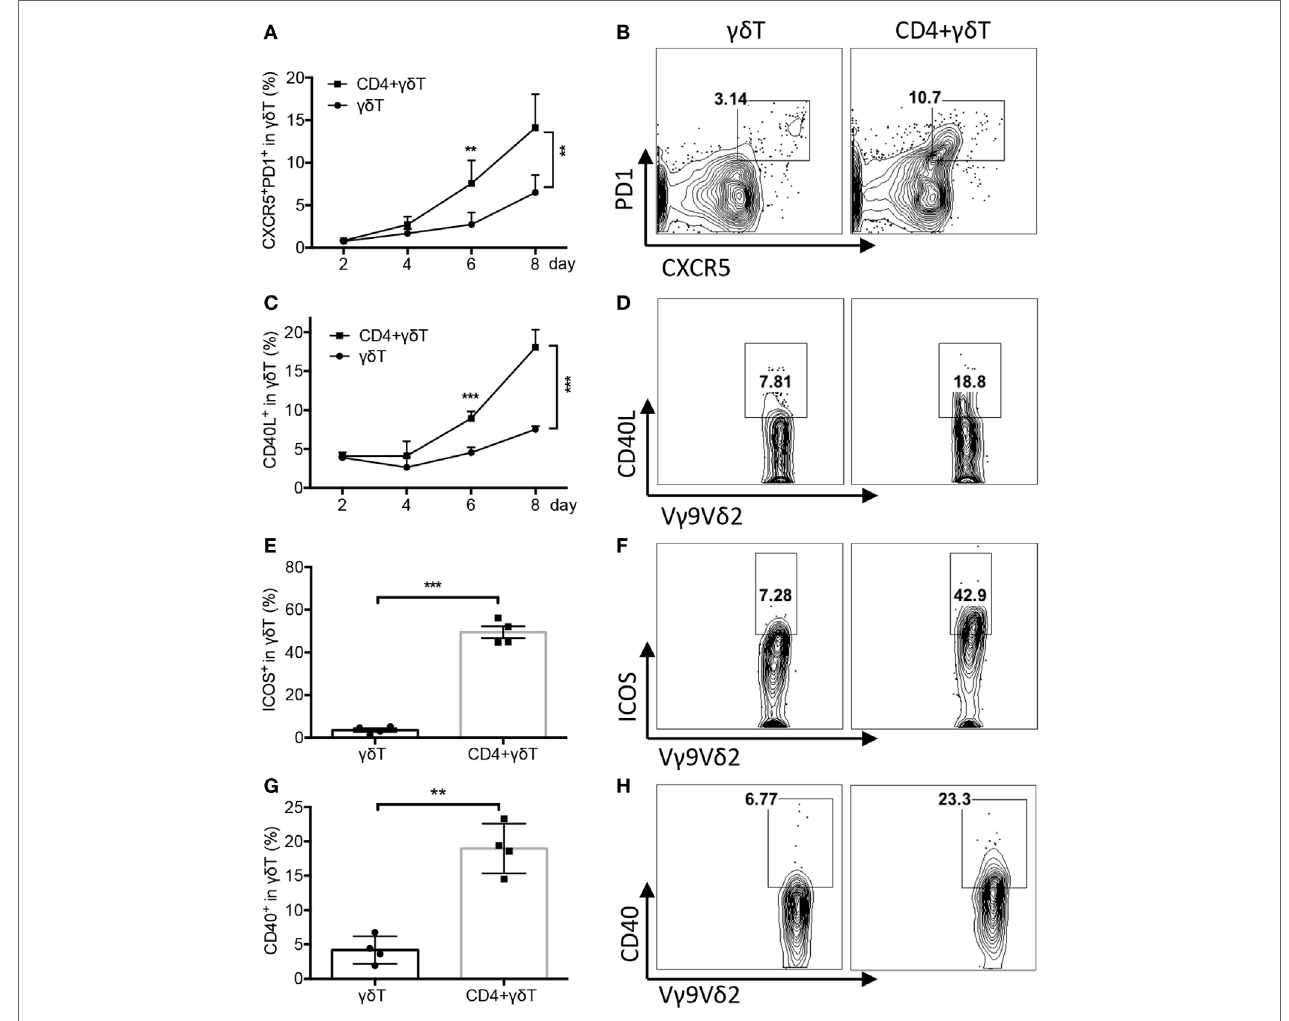
FigUre 3 | CD4 T cells promoted V γ 9V δ 2-T follicular helper cell differentiation. Naïve CD4 T cells were cultured with UV-H9N2 virus-pulsed dendritic cells for 4–5 days, then, the activated CD4 T cells were cultured with CD19 + B cells from same donor with or without V γ 9V δ 2-T cells for another 7–10 days. (a–D) Percentage of CXCR5 + PD1 + V γ 9V δ 2-T and CD40L + V γ 9V δ 2-T cells was detected by flow cytometry at different time points. FACS data showed the results of day 6. (e–h) Percentage of ICOS + V γ 9V δ 2-T cells and CD40 + V γ 9V δ 2-T cells was detected on day 4. n = 4 (e) , n = 3 (g) . FACS data represent 3–10 independent experiments. The data shown are the mean ± SEM. ** p < 0.01; *** p <